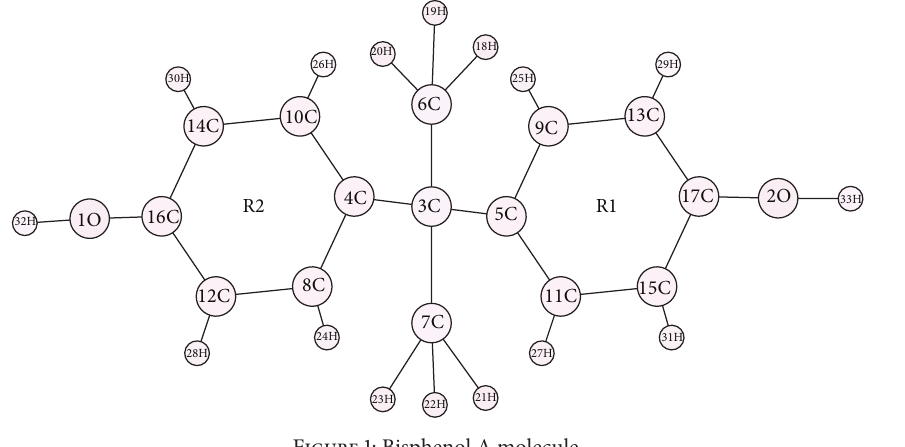
Figure 1: Bisphenol A molecule.